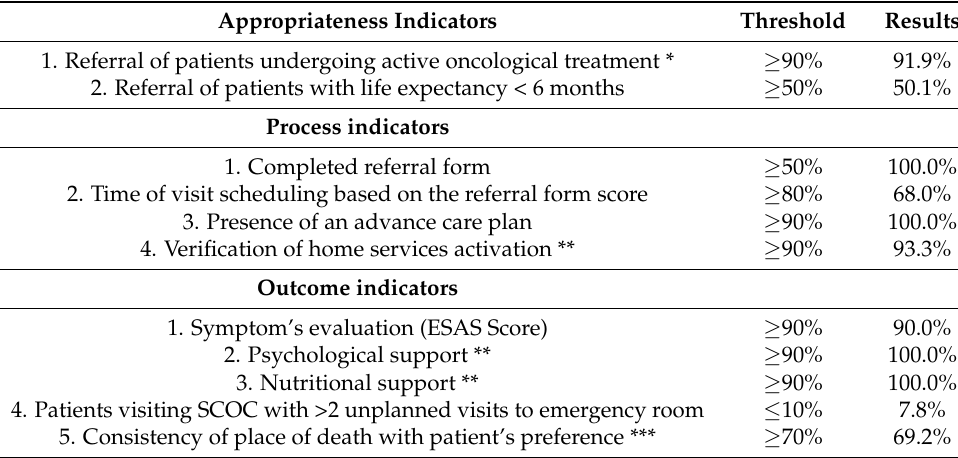
Table 3. Summary results of the indicators by procedure.